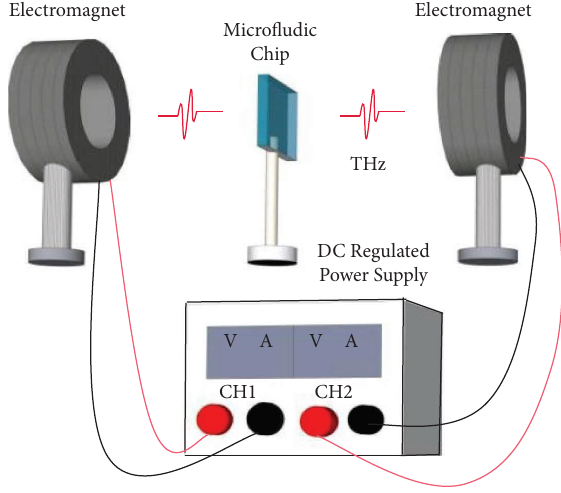
Figure 6: Diagram of an MF